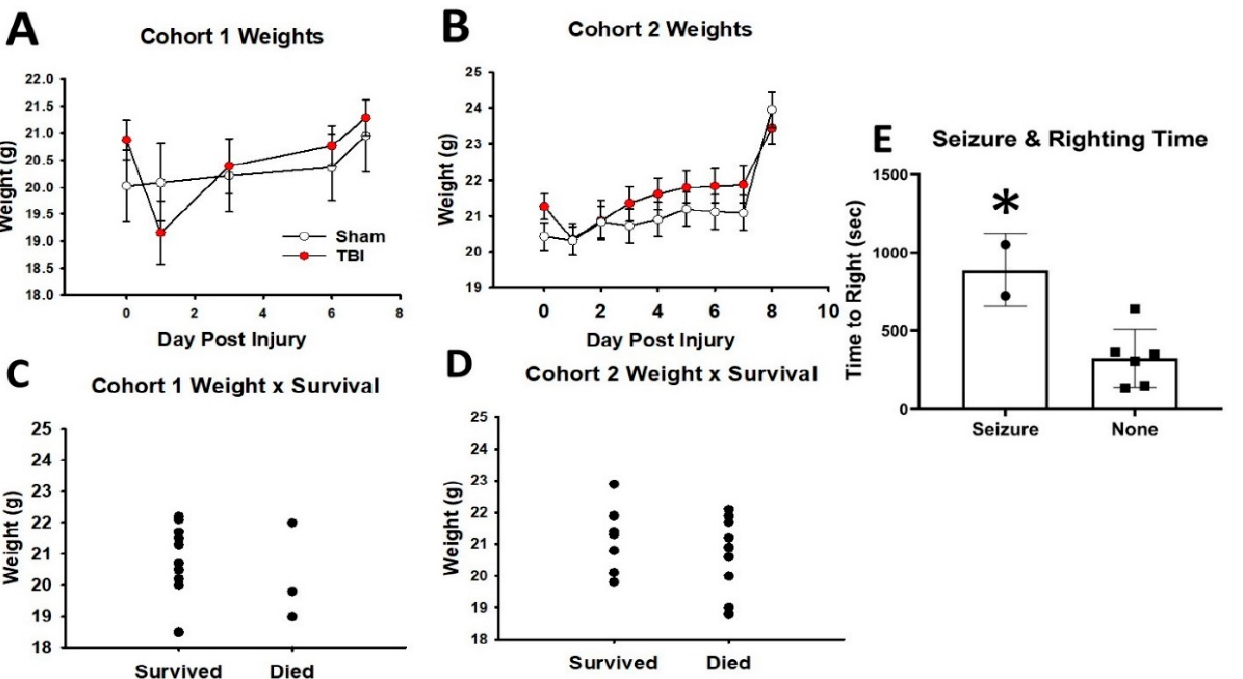
Figure 2. Weight, righting, and morbidity. For cohort 1 ( A ) and cohort 2 ( B ), there were no differences between sham and TBI in weight at any time up to 8 days after injury. Survival was not affected by the starting weight for cohort 1 ( C ) or cohort 2 ( D ). ( E ) The two mice who experienced seizures had significantly longer righting times ( β = 0.79). * indicates p < 0.05.